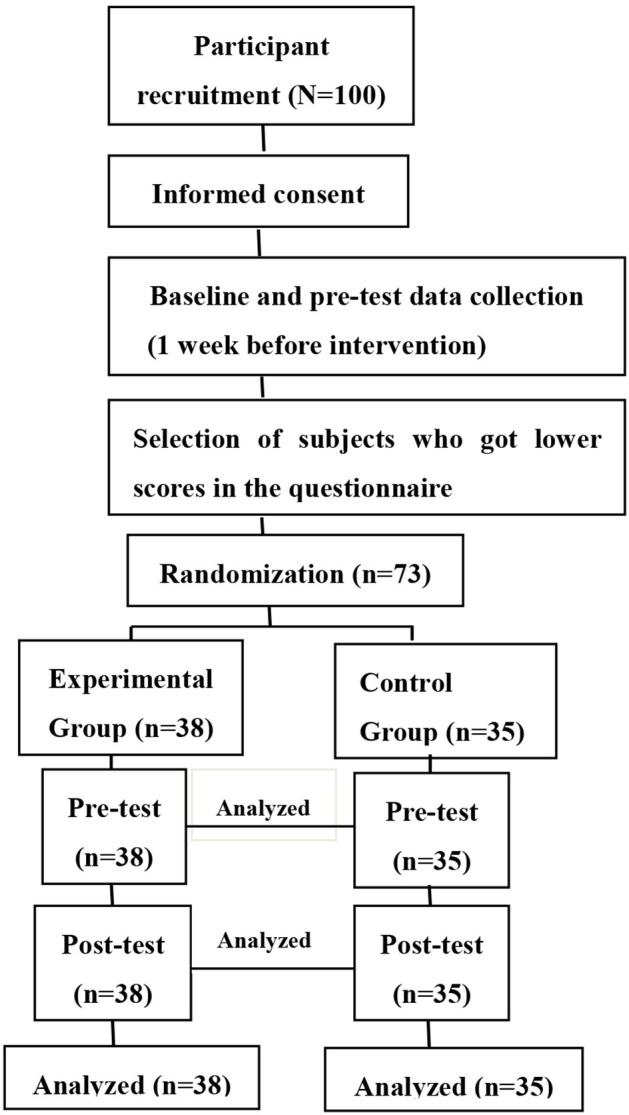
Flow of the experimental study with a randomized pre-post controlled design.